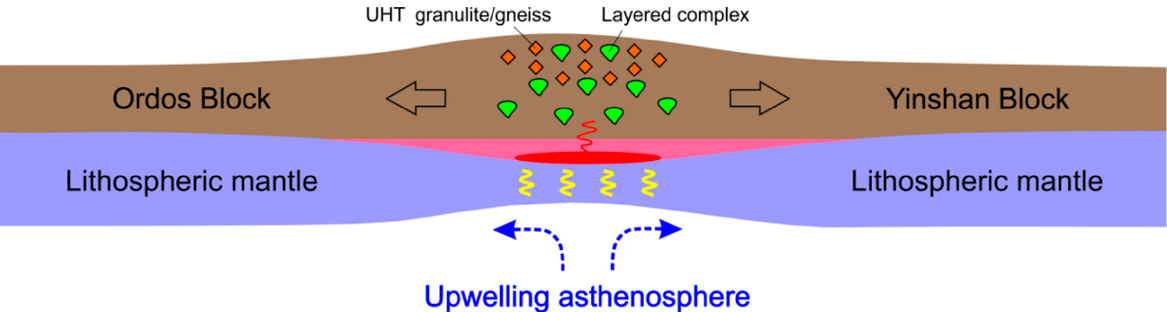
Figure 11. Cartoons showing the tectonic evolution of the Khondalite Belt between ~1.95 Ga and ~1.82 Ga.